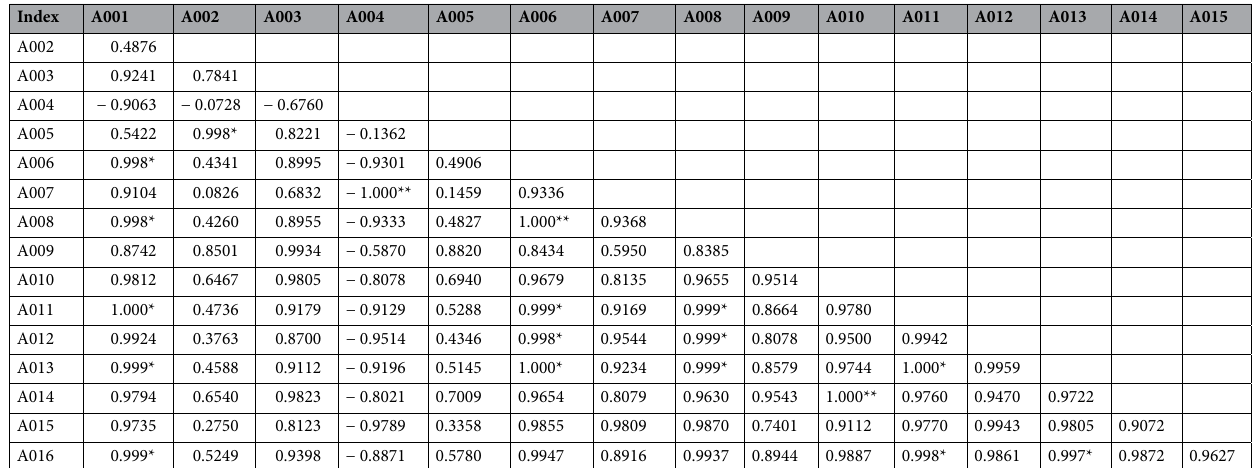
Table 5. Correlation analysis between the investigated parameters. * and ** significant at 0.05 and 0.01 level, respectively. A001: germination rate on May 10; A002: germination rate on May 12; A003: germination rate on May 13; A004: germination rate on May 14; A005: plant height; A006: leaf area; V007: aboveground dry mass; A008: root dry mass; A009: root/shoot ratio; A010: grain yield; A011: average temperature at 50 mm soil depth during warming stage; A012: average temperature at 100 mm soil depth during warming stage; A013: average temperature at 150 mm soil depth during warming stage; A014: average temperature at 50 mm